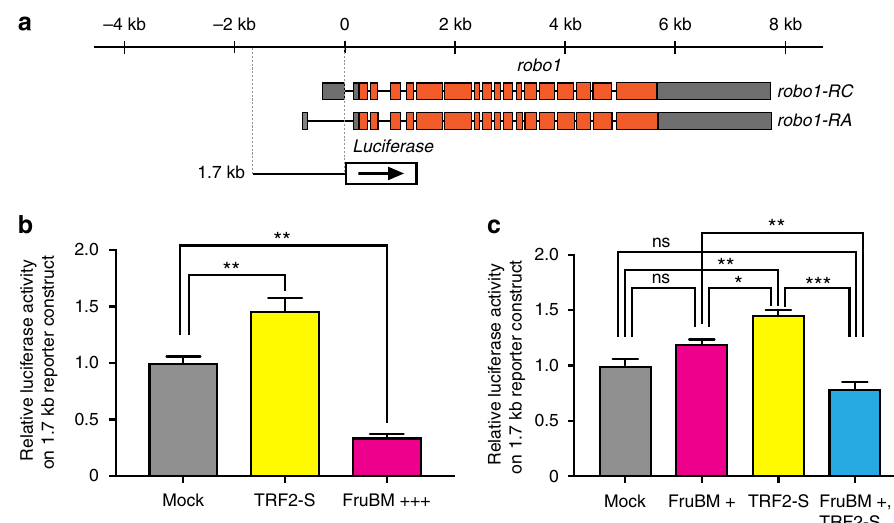
Fig. 4 TRF2-S and FruBM regulate transcription from the robo1 promoter. a Schematic representation of the exon – intron organization for two robo1 transcripts ( robo1-RA and robo1-RC ) and the robo1 reporter construct. b A luciferase reporter fused to the robo1 promoter fragment of 1.7 kb exhibited an elevated transcription in the presence of TRF2-S alone and a reduced transcription in the presence of FruBM alone. c A lower dose of FruBM, which by itself had no effect on the reporter activity, was able to exert a strong repressor effect in the presence of TRF2-S. All experiments were conducted as triplicate and the mean ± SEM of relative luciferase activities are shown. Statistical differences were evaluated by one-way ANOVA followed by Bonferroni ’ s